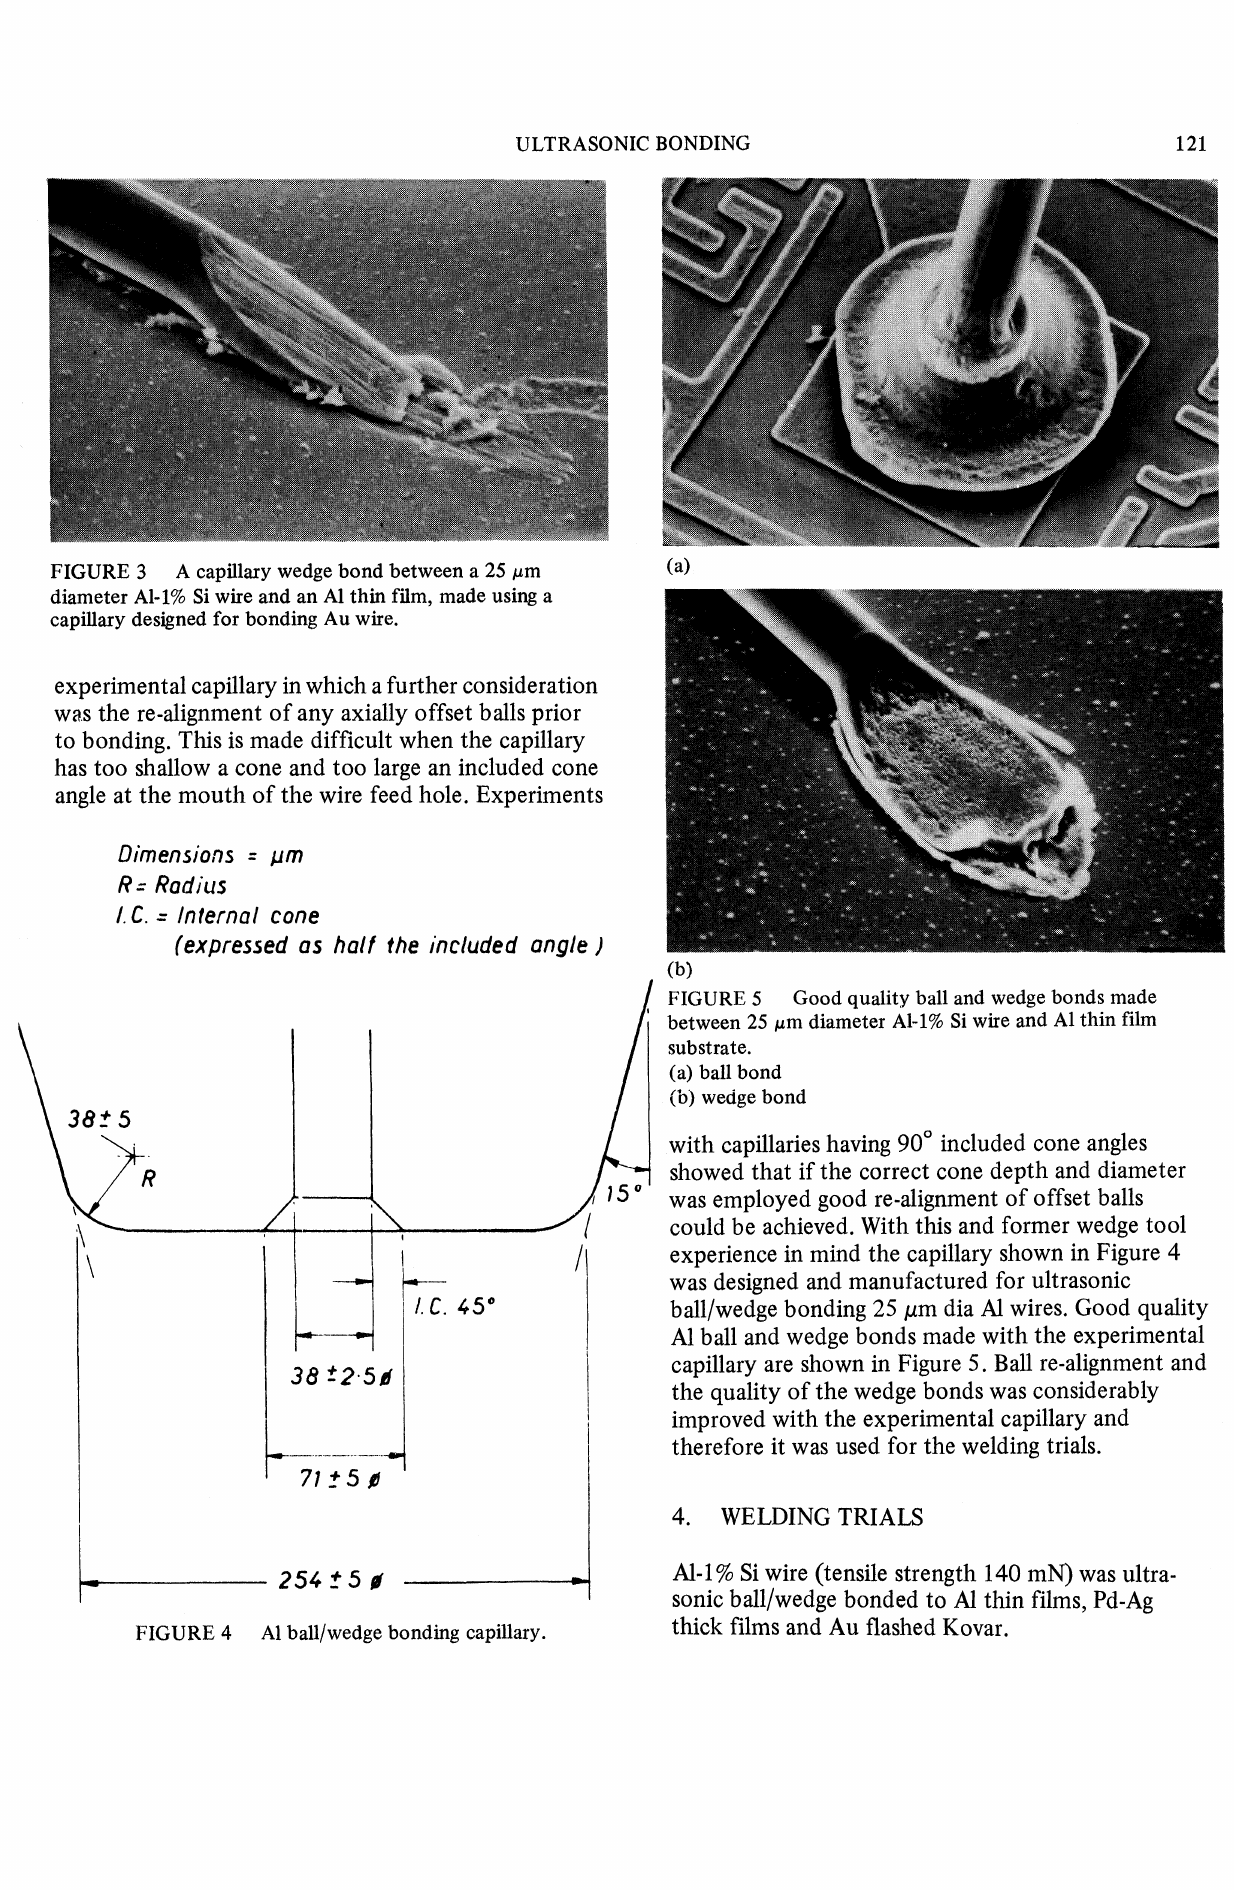
FIGURE 3 A capillary wedge bond between a 25 diameter Al-l% Si wire and an A1 thin film, made using a capillary designed for bonding Au wire.